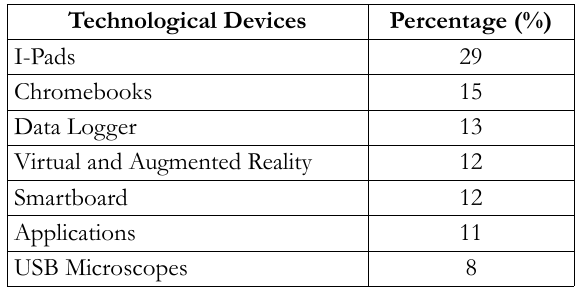
Table 11. Percentage of devices being used in the classroom (Questionnaire)